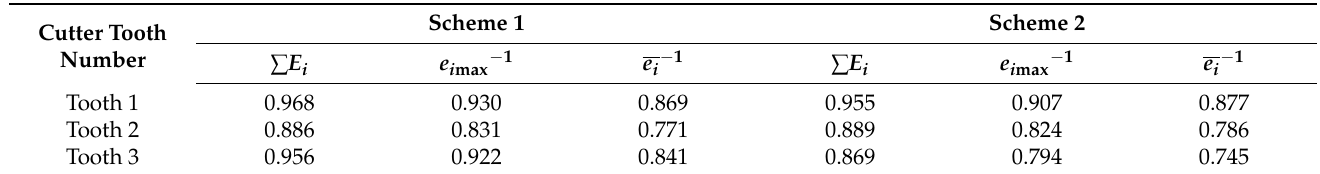
Table 4. Correlation between cumulative wear depth and friction wear energy density.